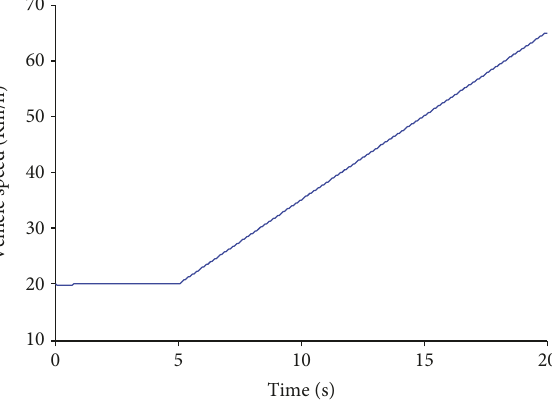
Figure 17: Comparison of vehicle yaw rate.